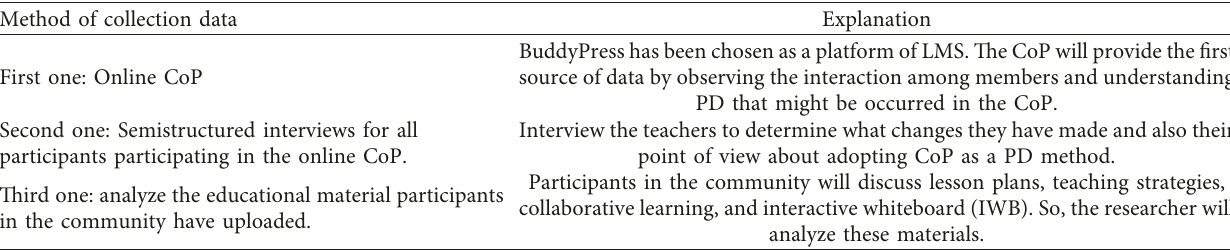
Table 2: Techniques and source of data